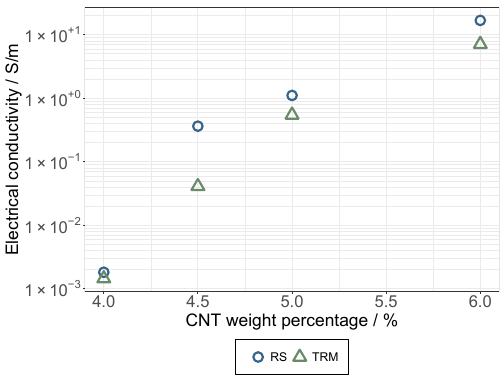
Figure 5. Percolation curves of dried films (CA system), prepared with RS and TRM. For the rotor-stator method, the percolation curves were slightly shifted towards the lower necessary CNT proportions. This is an indication that, with the current parameters, dispersion by means of a rotor-stator system has slight